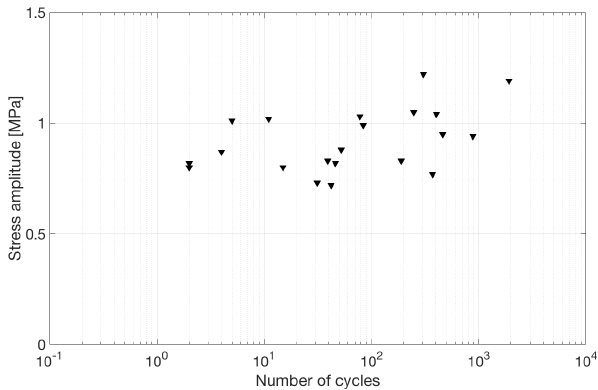
Figure 12. Acoustic emissions (hits) against time for saline ice of lower salinity (3.0 ± 0.9ppt), cycled at a stress amplitude of 0.5MPa at − 10 ◦ C at an outer-fiber displacement rate of 0.1mms − 1